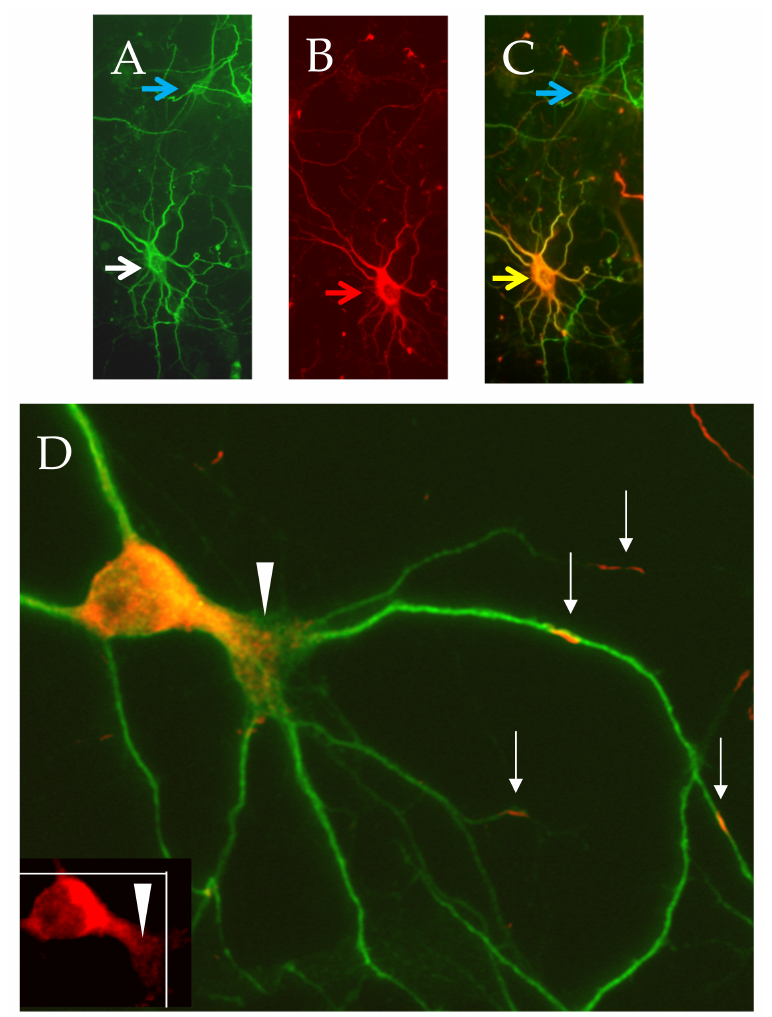
Figure 3. CRMP3-mediated dendritic activity. Representative CRMP3-transfected neurons were immunostained for dendritic marker MAP2 (( A ) white arrow and Flag-CRMP3; ( B ) red arrow). Overlay images of transfected neurons are in orange (( C ) yellow arrow; untransfected neuron: blue arrow). Flag-CRMP3 transfected neurons are characterized by an increase in lamellopodial/dendritic formation (( D ), white arrows heads). Interestingly, the protein did not exhibit passive lateral diffusion but presented as consistent puncta over long distances in the soma and the dendrites with some extending up to the dendritic tips suggesting an active transport of the protein into dendrites (( D ) white